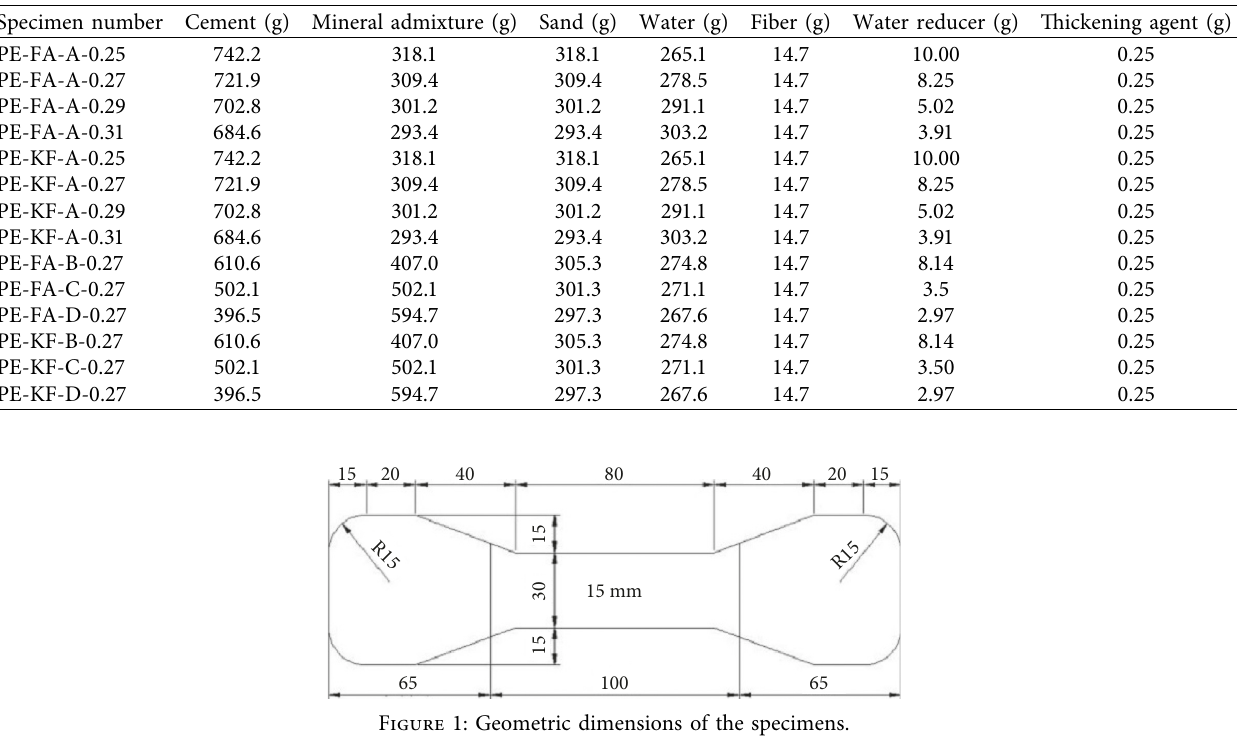
Table 5: Mix proportions of PE-ECC.